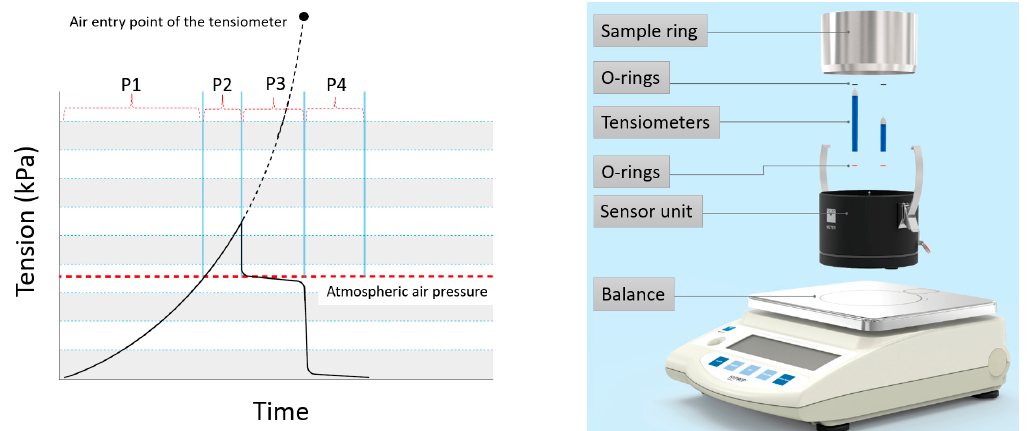
Figure 1. Hydraulic Property Analyzer (HYPROP) system components ( right ) and the four typical phases (P1 to P4) of a measurement campaign ( left ) for the optimal measuring curve including the regular measurement range phase (P1), the boiling delay phase (P2), the cavitation phase (P3) and the air entry phase (P4), adapted from HYPROP user manual [50].